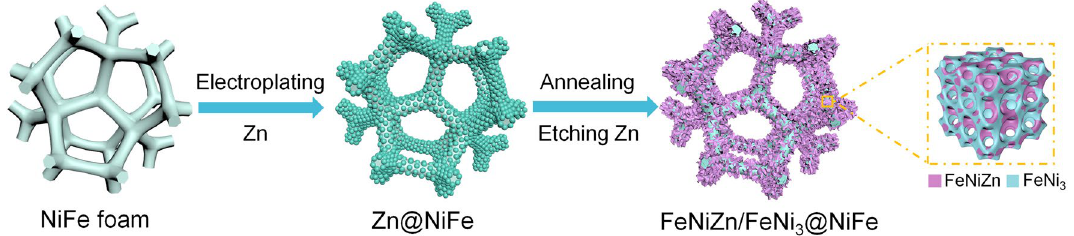
Fig. 1 Preparation scheme of FeNiZn/FeNi 3